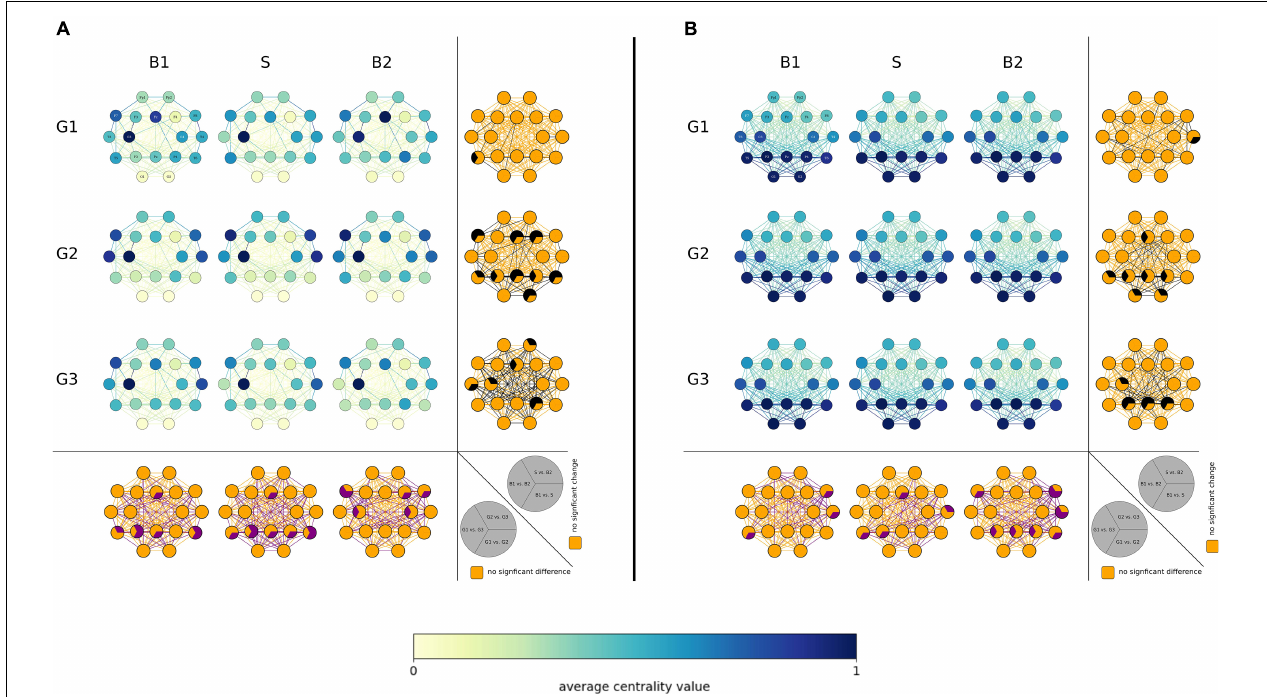
FIGURE 3 | Local network characteristics. [ (A) Betweenness centrality C B and (B) eigenvector centrality C E ] of the three investigated groups (G1 = focal epilepsy group, G2 = generalized epilepsy group, G3 = non-epilepsy group) in the three investigated phases (B1 = pre-stimulation baseline 1, S = stimulation, B2 = post-stimulation baseline 2). Network vertices arranged according the international 10–20 system for EEG-recording (electrode naming see first plot). Color coding of vertices and edges according to the average centrality values. Bottom: Difference between groups (G1, G2, G3) for local network characteristics in the three investigated phases. Orange: no significance, purple: significant difference ( p < 0.05). Right side each plot: Differences between phases (B1, S, B2) for local network characteristics in the three investigated groups. Orange: no significance, black: significant change ( p < 0.05).